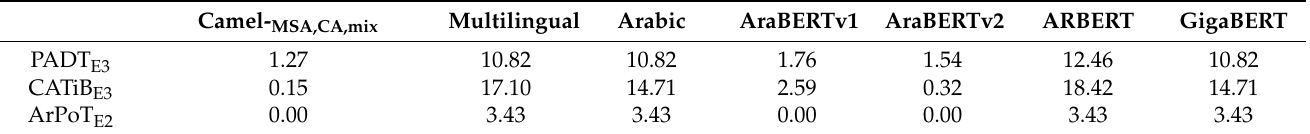
Table 11. The rate of OOV tokens indicated by each model over the fine-tuning